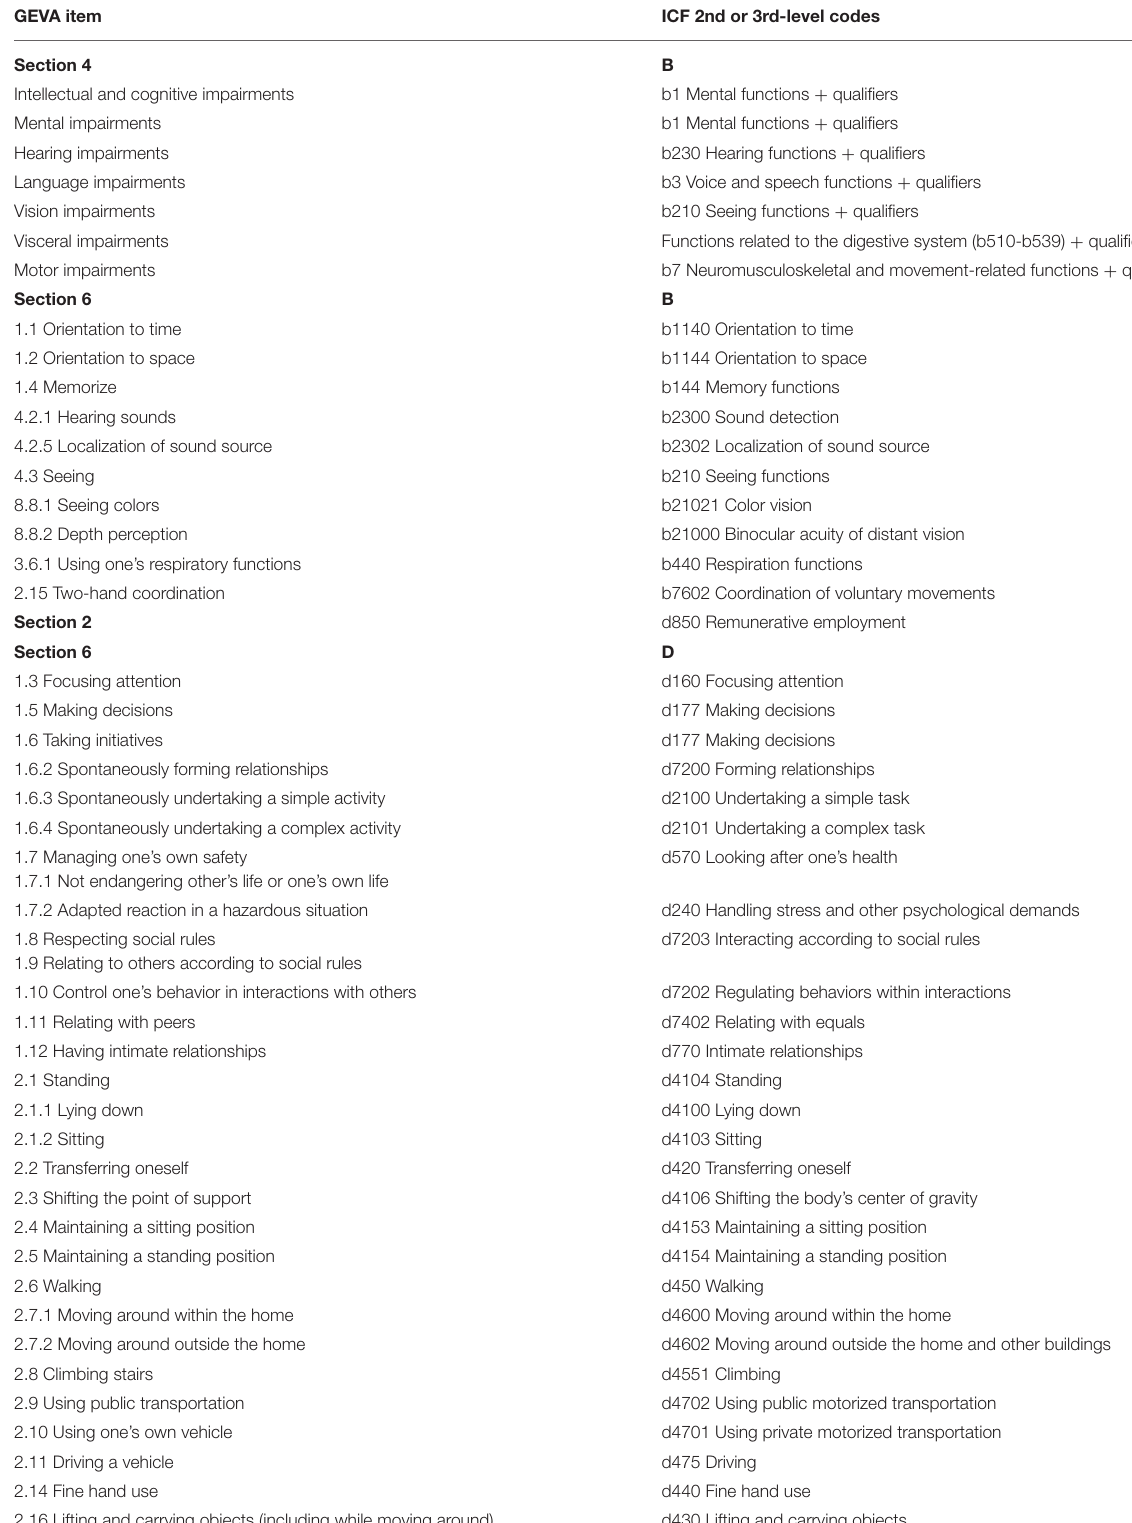
TABLE 2 | GEVA items covered by ICF categories (exact